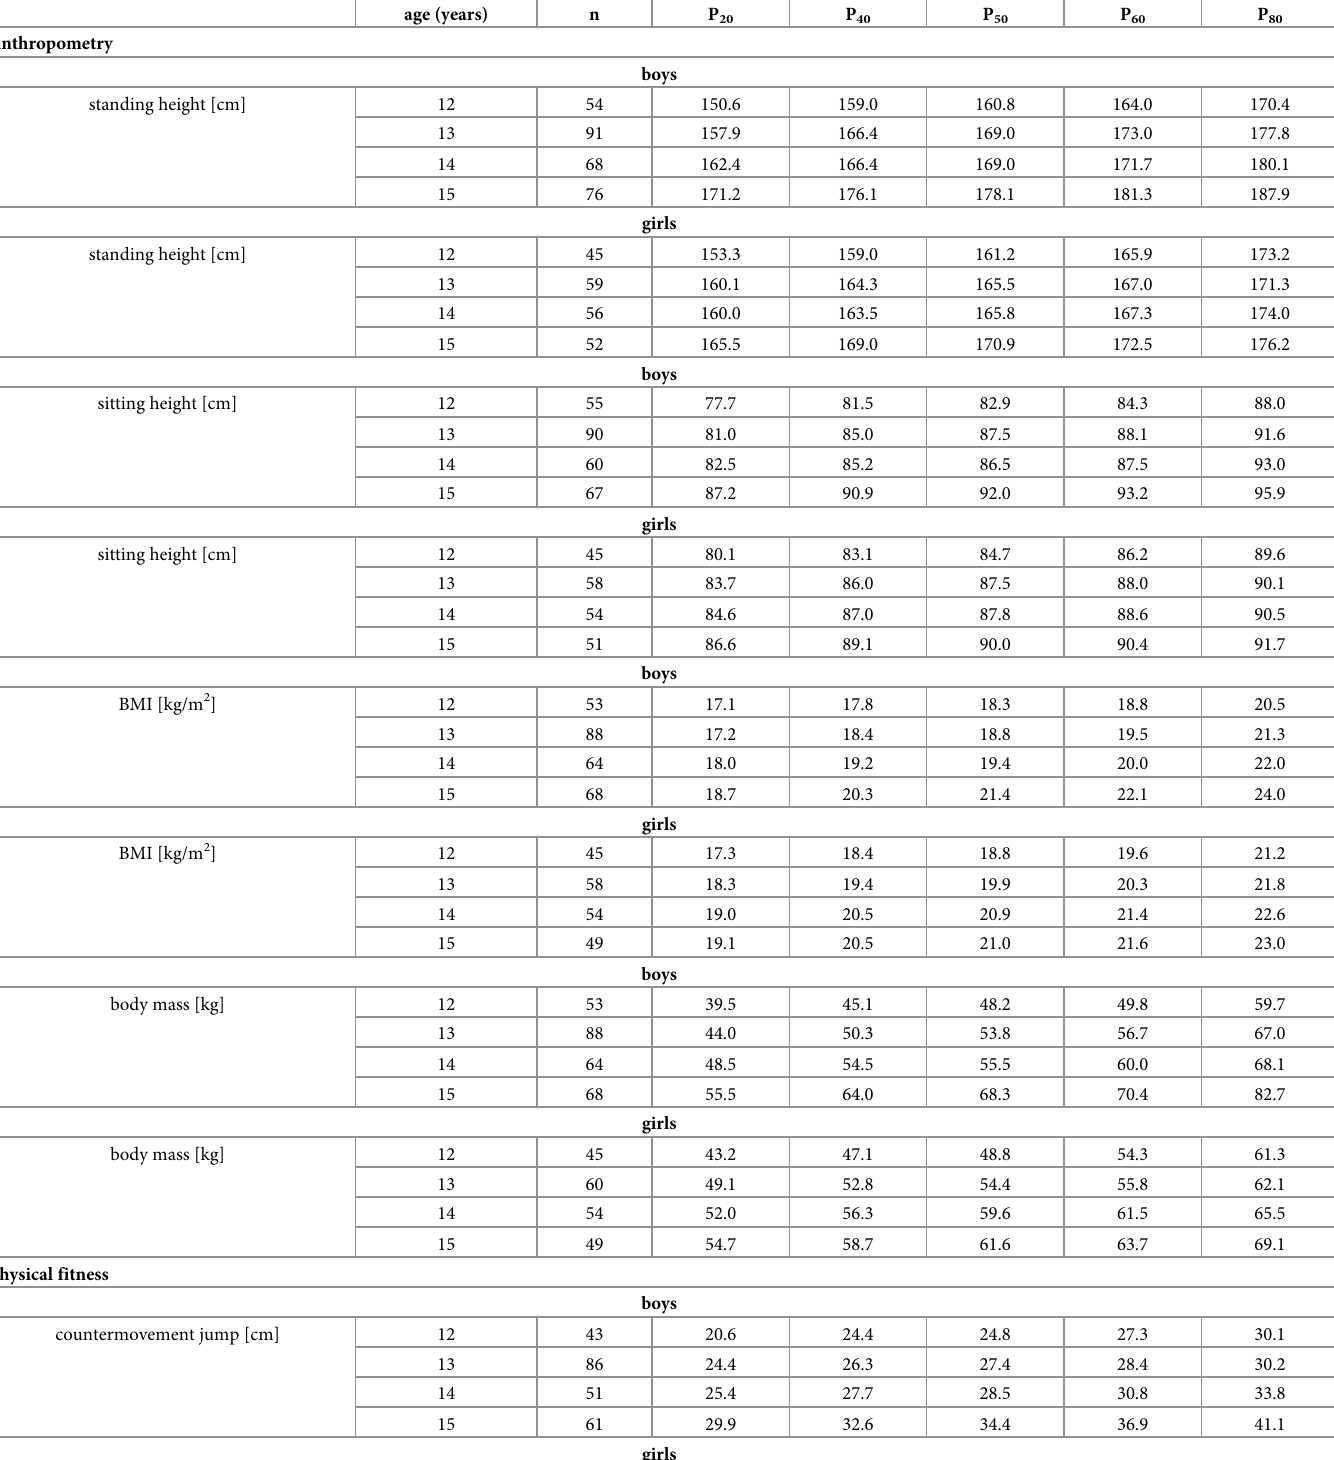
Table 3. Sex- and chronological age-specific anthropometric and physical fitness percentiles of German elite young athletes. age (years) n P 20 Anthropometry standing height